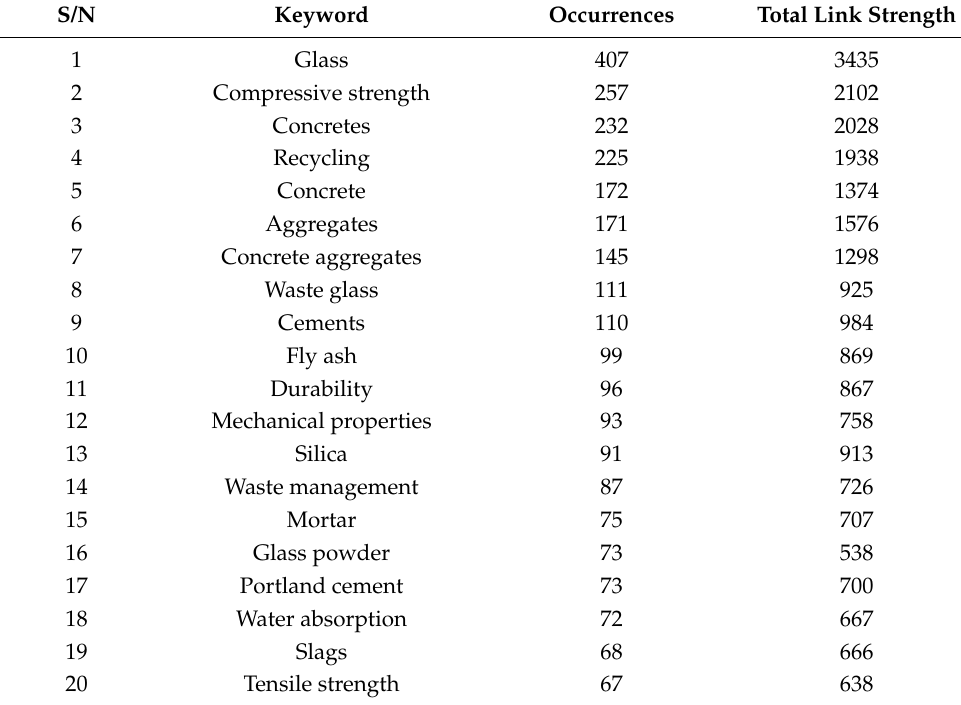
Table 2. Top 20 most occurred